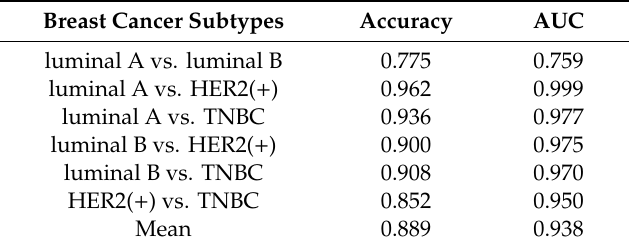
Table 7. The accuracy and AUC of any two breast cancer subtypes with multi-omics data by DeepMO on test data.